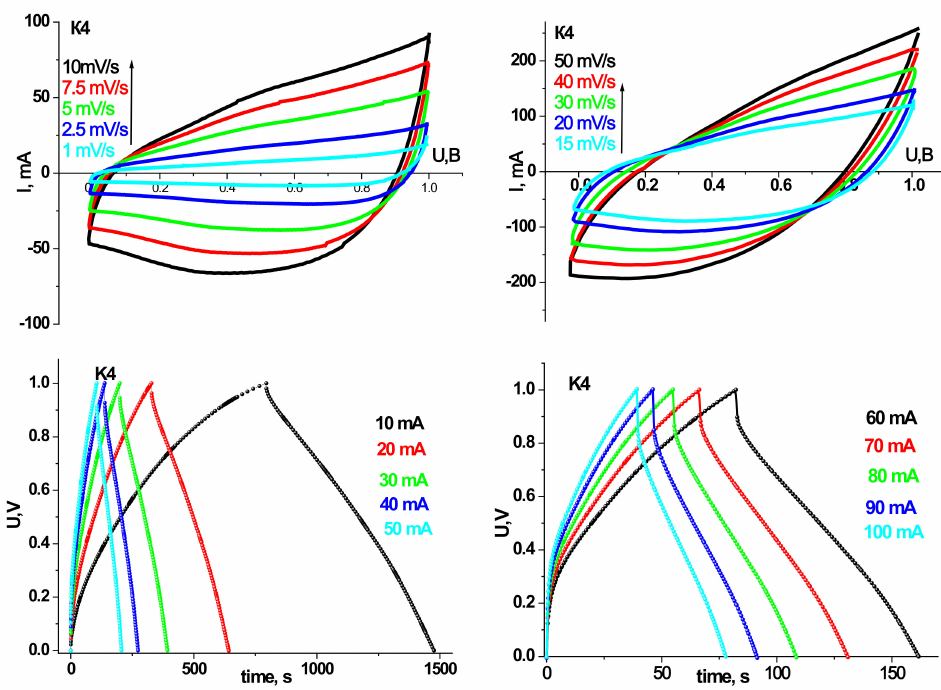
Figure 10. CVA and charge/discharge curves of the layout of HSCs based on the material K4. Tables 3 and 4 summarize the models’ specific capacity characteristics HSCs on synthe- sized materials at different annealing temperatures obtained from cyclic voltammograms and galvanostatic charge/discharge